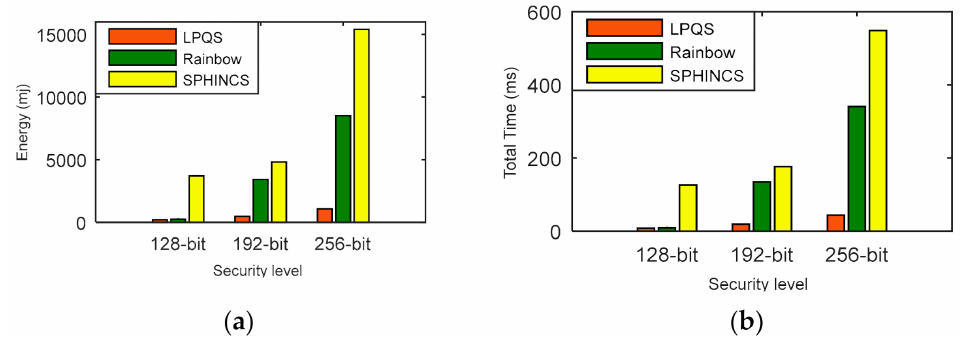
Figure 8. ( a ) Energy consumption, ( b ) computation time comparison of LPQS with nonisogeny based methods. Table 7. Comparison of total energy (mJ) with postquantum techniques at different security